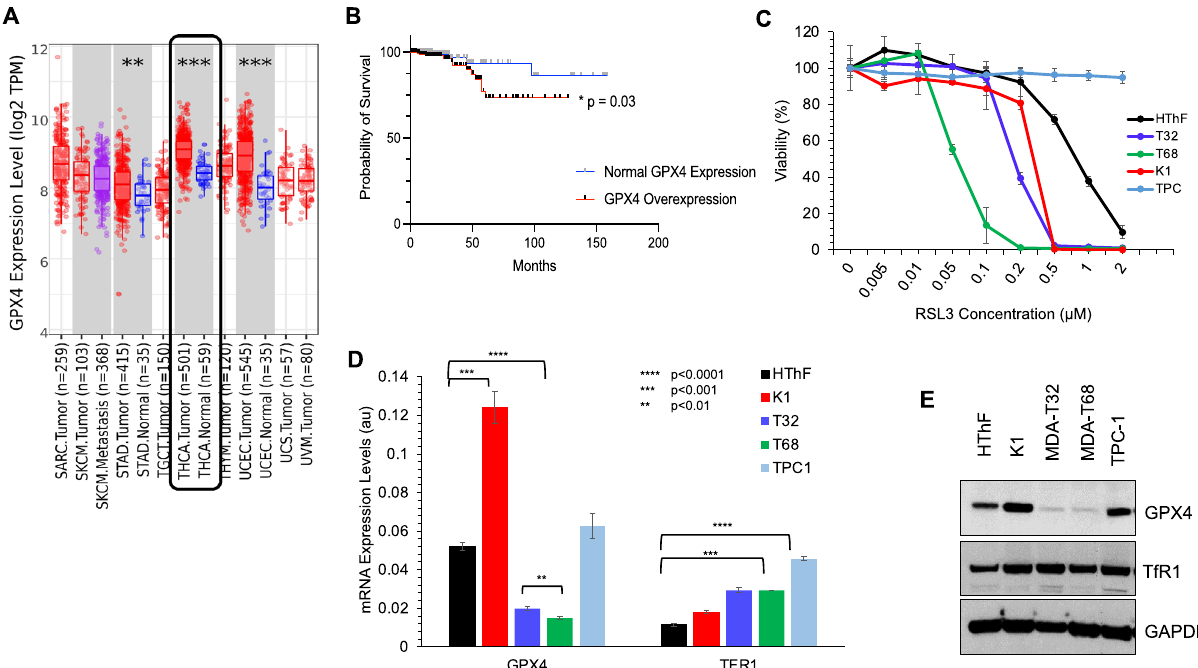
Figure 1. GPX4 and TfR1 expression levels in papillary thyroid carcinoma. ( A ) TIMER2.0 data analysis from TCGA database of Papillary Thyroid Carcinomas (N = 501) showing estimated GPX4 mRNA expression levels in thyroid cancer (black box) compared to the normal thyroid tissue (N = 59) (log 2 fold change 9.7 vs 8.2, p < 0.001). ( B ). GPX4 overexpression is associated with worse 5-year OS (73% vs 97%; HR 2.95; 95% CI 2.1–7.9; p = 0.03). ( C ) Viability assay of thyroid cancer cell lines K1, MDA-T32, MDA-T68, TPC-1 and HThF control cells after treatment with RSL3 for 48 h. ( D ) RT-qPCR for GPX4 and transferrin receptor 1 ( TfR1 ) mRNA levels, normalized to β-actin, in K1, MDA-T32, MDA-T68, and TPC-1 cancer cell lines, as well as human thyroid fibroblasts (HThF) (* p < 0.05, ** p < 0.01, *** p < 0.001, **** p < 0.0001, ns— p > 0.05). E Protein levels for GPX4 and TfR1 measured by Western blot